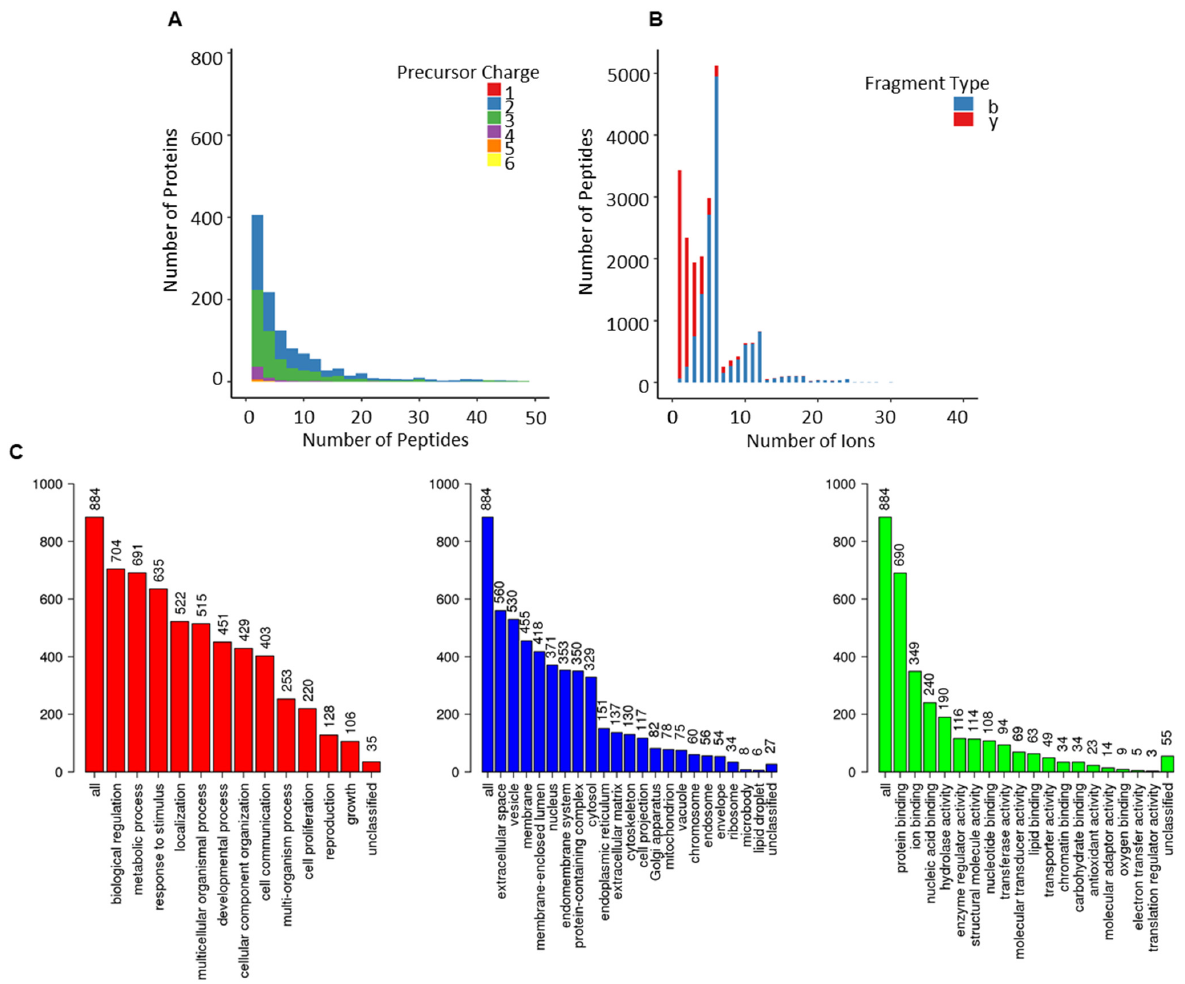
Figure 3. Overview of combined-PCa serum spectral library. ( A ) Frequency distribution of peptides per protein; ( B ) ion per peptides; ( C ) gene ontological analyses of the proteotypic proteins from combined-PCa library mapped using the WebGestalt Webserver. The biological processes, cellular processes and molecular function categories are shown, where the height of each bar represents the percentage of mapped IDs per category.